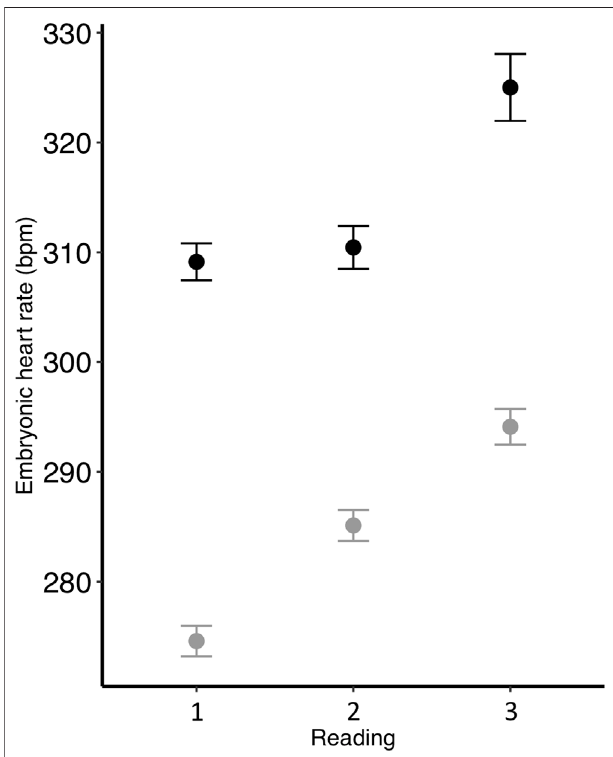
FIGURE 1 | Zebra fi nch embryonic heart rate (beats per minute; bpm) at three different time points during development and incubated at two different temperatures (black = control; gray = low). To correct for different developmental rates, readings were taken on control eggs after (1) 11, (2) 12, and (3) 13 days of incubation, while readings were taken on low eggs after (1) 12, (2) 13, and (3) 14 days. Mean ± SE are shown.